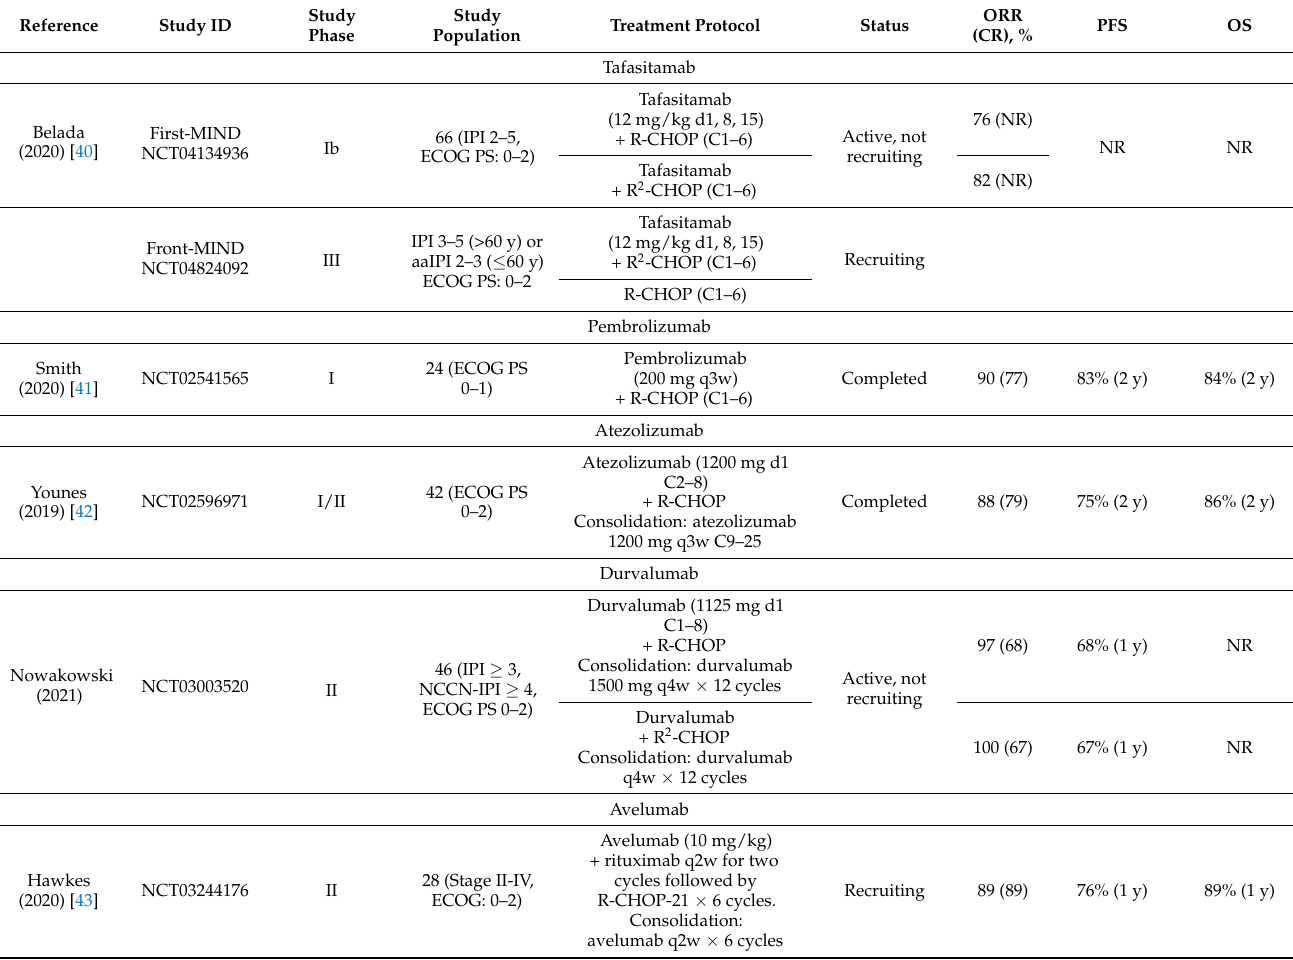
Table 2. Clinical trials evaluating the efficacy of monoclonal antibodies in patients with newly diagnosed